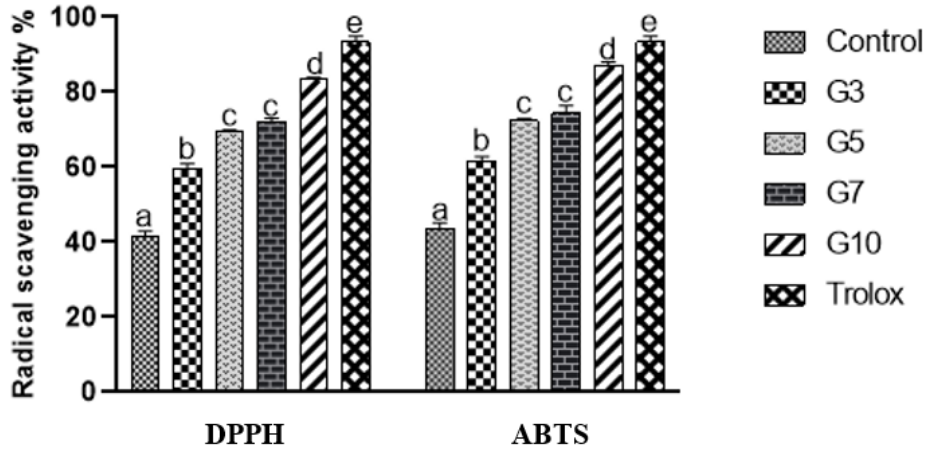
Figure 1. Antioxidant capacity of cream soup supplemented with ginseng powder. Two radical scavenging assays DPPH and ABTS were performed. The graphs are expressed as mean value ± S.D. of triplicate experiments in percentage. Values represent triplicate readings and different small letters in the figure denote significant differences ( p < 0.05). Control: soup without ginseng powder; GS3: Soup with 3% ginseng powder; GS5: Soup with 5% ginseng powder; GS7: Soup with 7% ginseng powder; GS10: Soup with 10% ginseng powder.